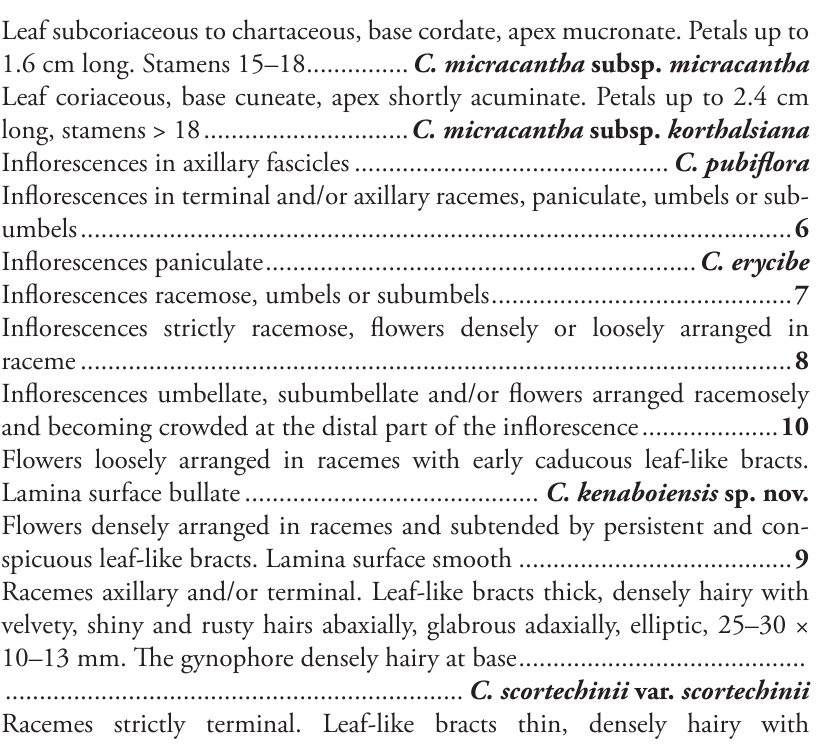
Leaf subcoriaceous to chartaceous, base cordate, apex mucronate. Petals up to Leaf coriaceous, base cuneate, apex shortly acuminate. Petals up to 2.4 cm